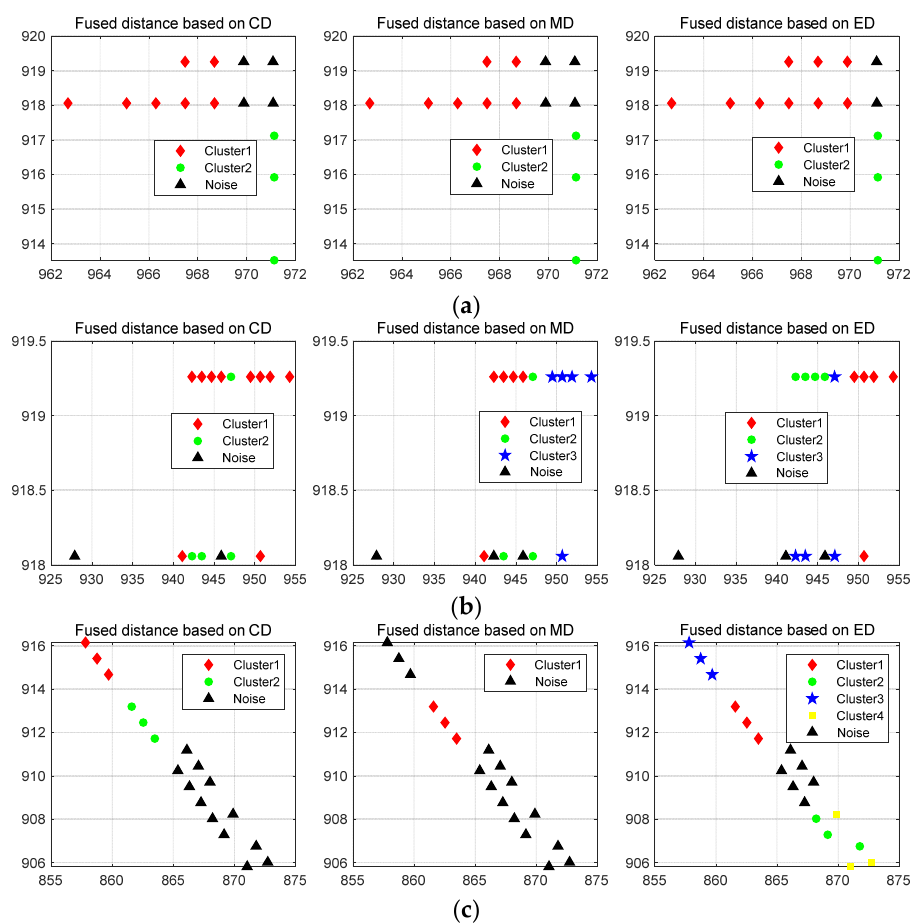
Figure 11. Clustering results of three positioning methods, ( a ) case 1, ( b ) case 2, and ( c ) case 3. In Figure 11a, the number of clusters based on three fused distances,